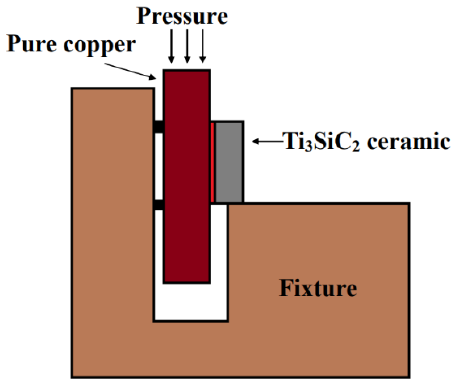
Figure 3. Schematic diagram of shear strength test.